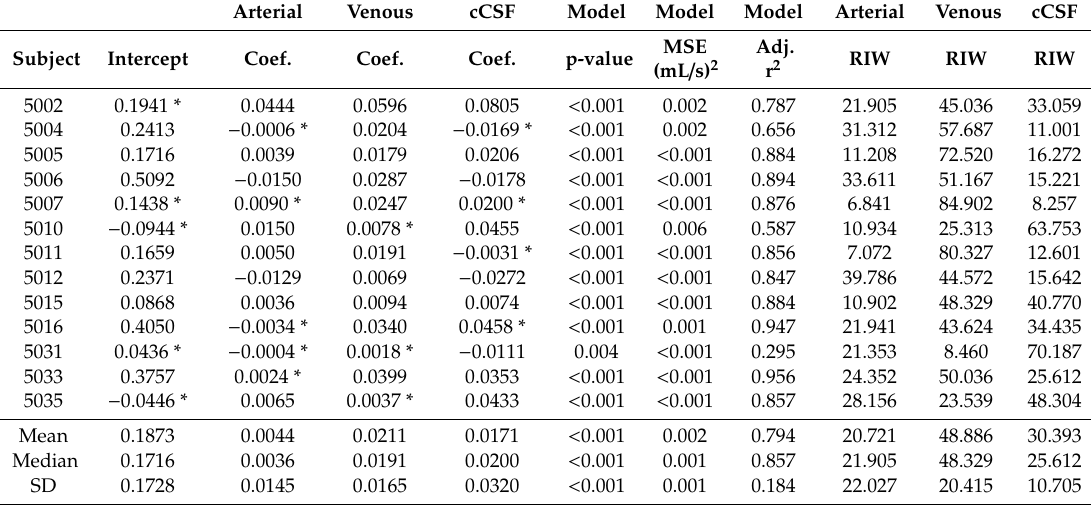
Table 4. Coe ffi cients and relative importance weights for the respective arterial, venous and cCSF signals, together with the model adjusted r 2 values for the respective